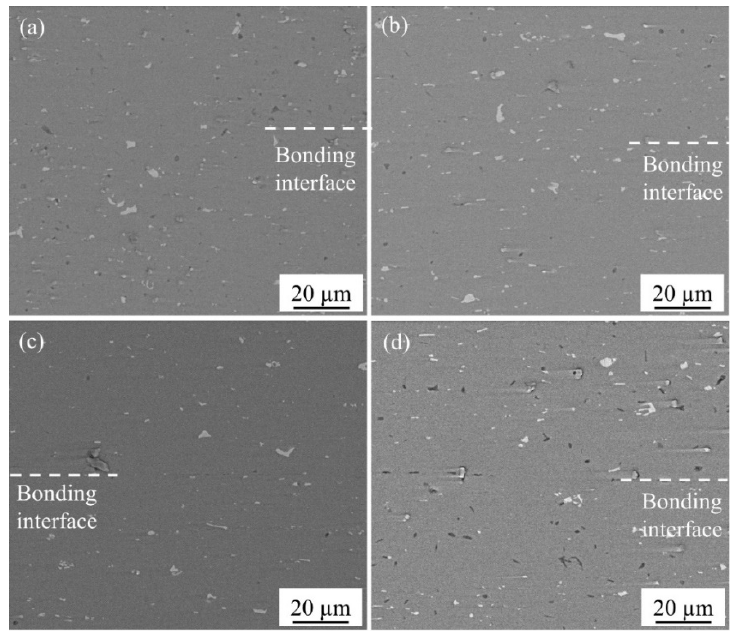
Figure 3. Microstructures of AA6061/AA6061 bonding interfaces after diffusion bonding at ( a ) 500 ◦ C,